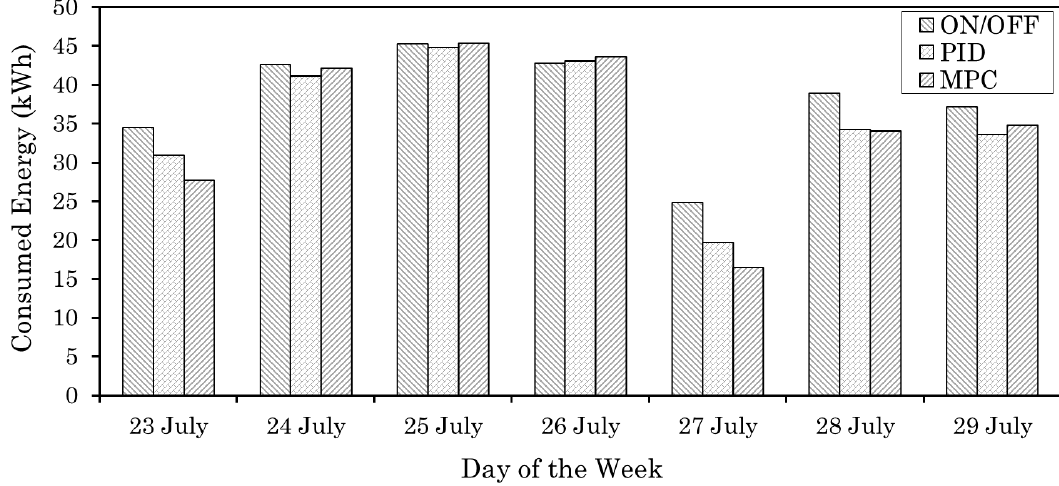
Figure 16. The daily consumed energy by ON/OFF, PID and MPC of the whole studied week.